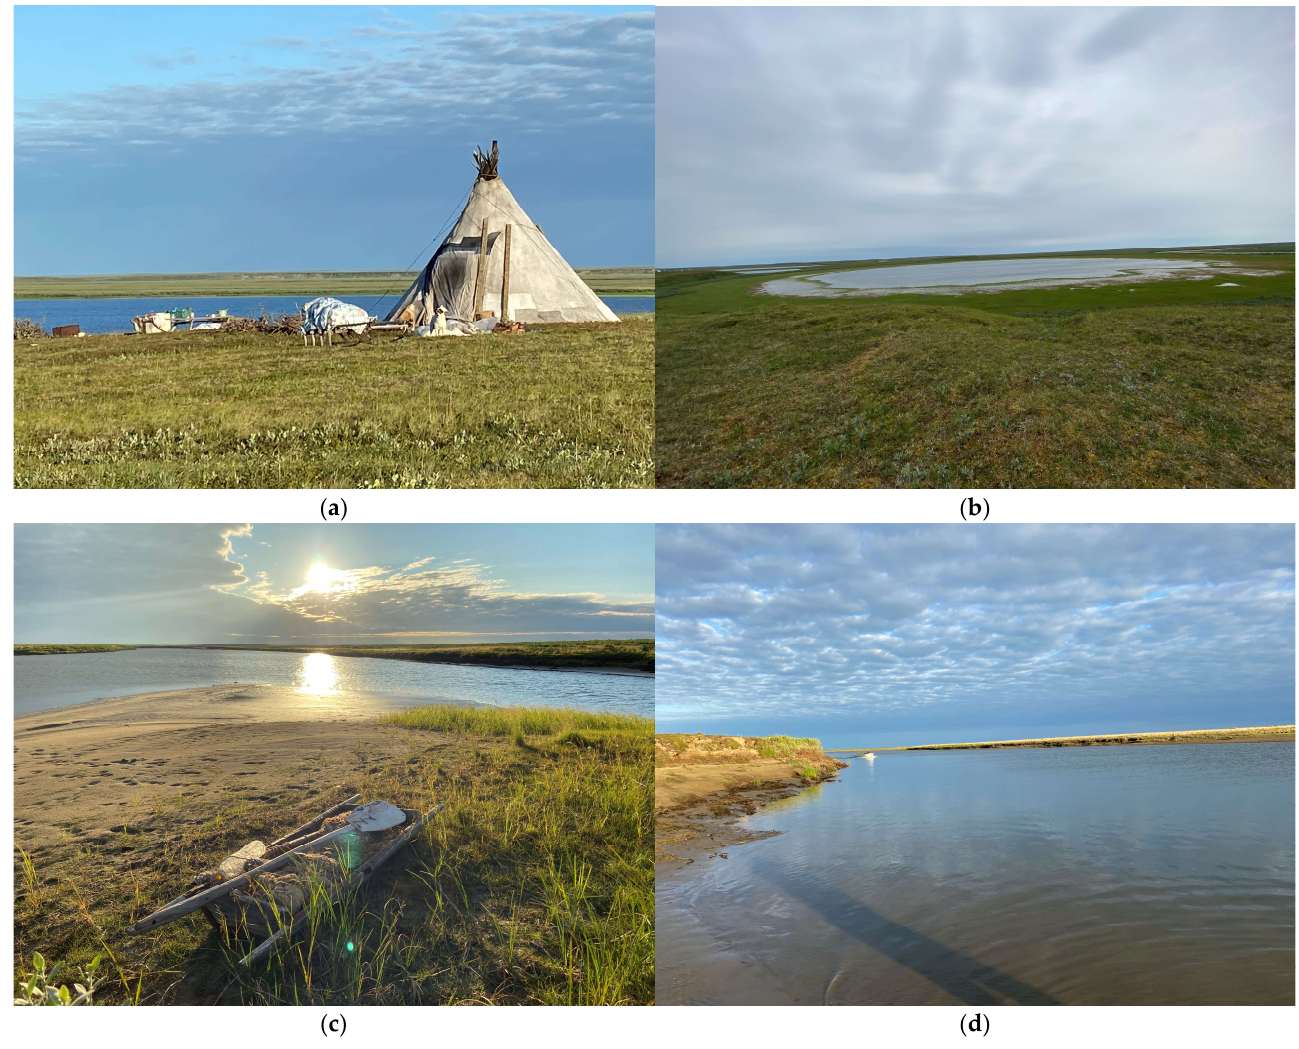
Figure 3. River and lake water sources in the YNAO (Gydansky Peninsula, expedition in August 2022). ( a ) Chum at the Gyda River. ( b ) Small thermokarsk lake near the chum. ( c ) Sandy banks and vegetation of the Gyda River. ( d ) The expanse of the Gyda River.